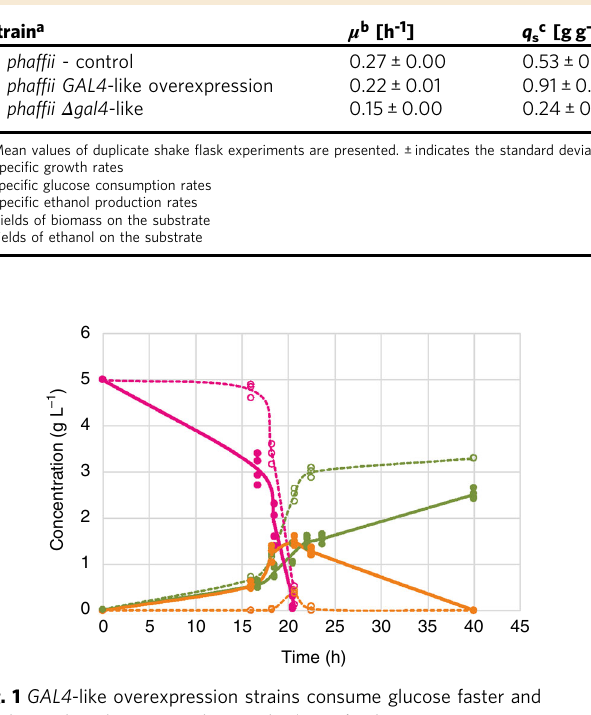
Table 1 Overexpression or deletion of the GAL4 -like TF gene changes the phenotype of K. phaf fi i